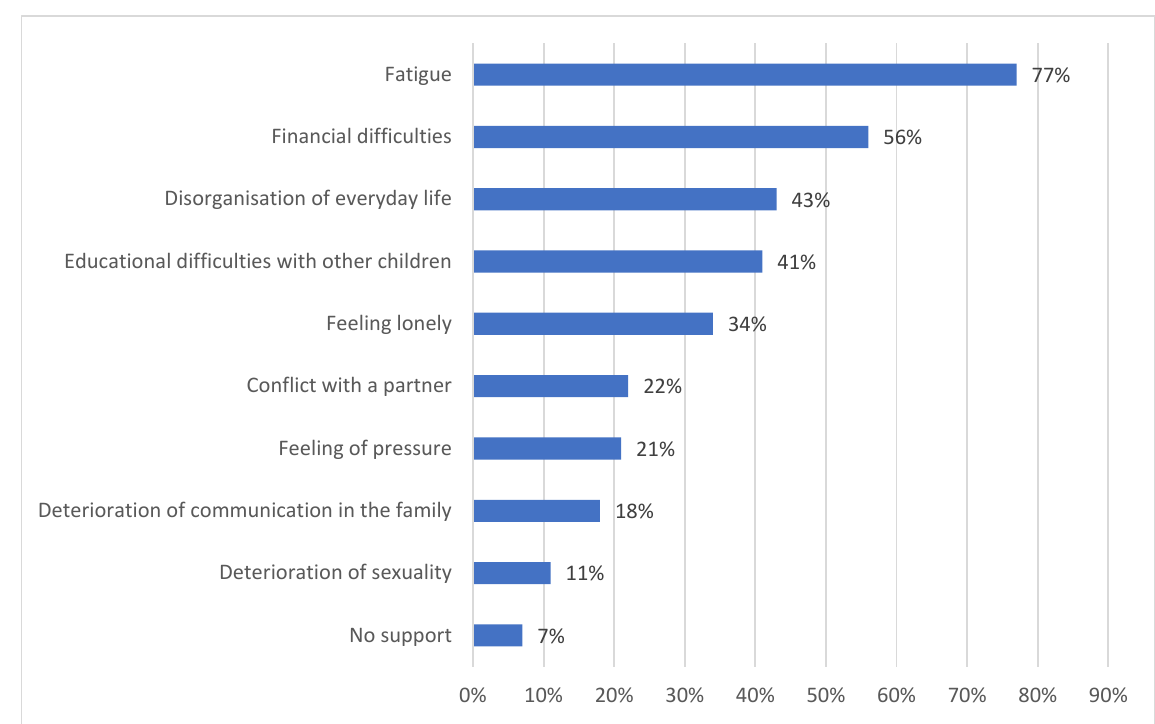
Figure 4. The source of family conflicts.